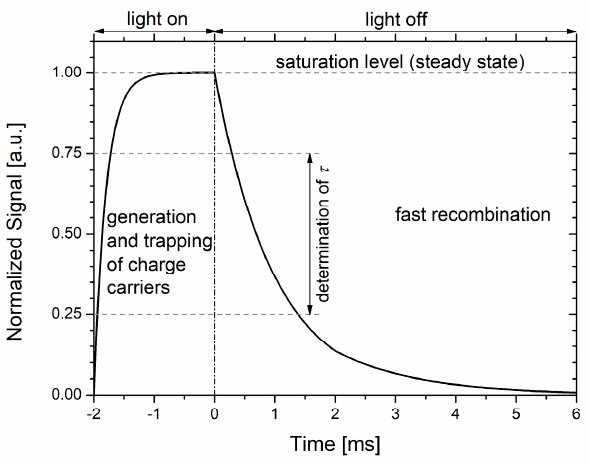
Figure 1. Exemplary microwave detected photoconductivity (MDP) measurement transient.